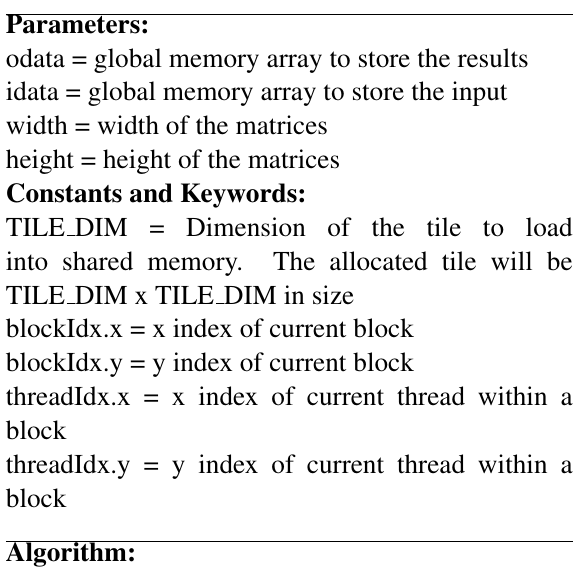
Algorithm 2 Parallel Write